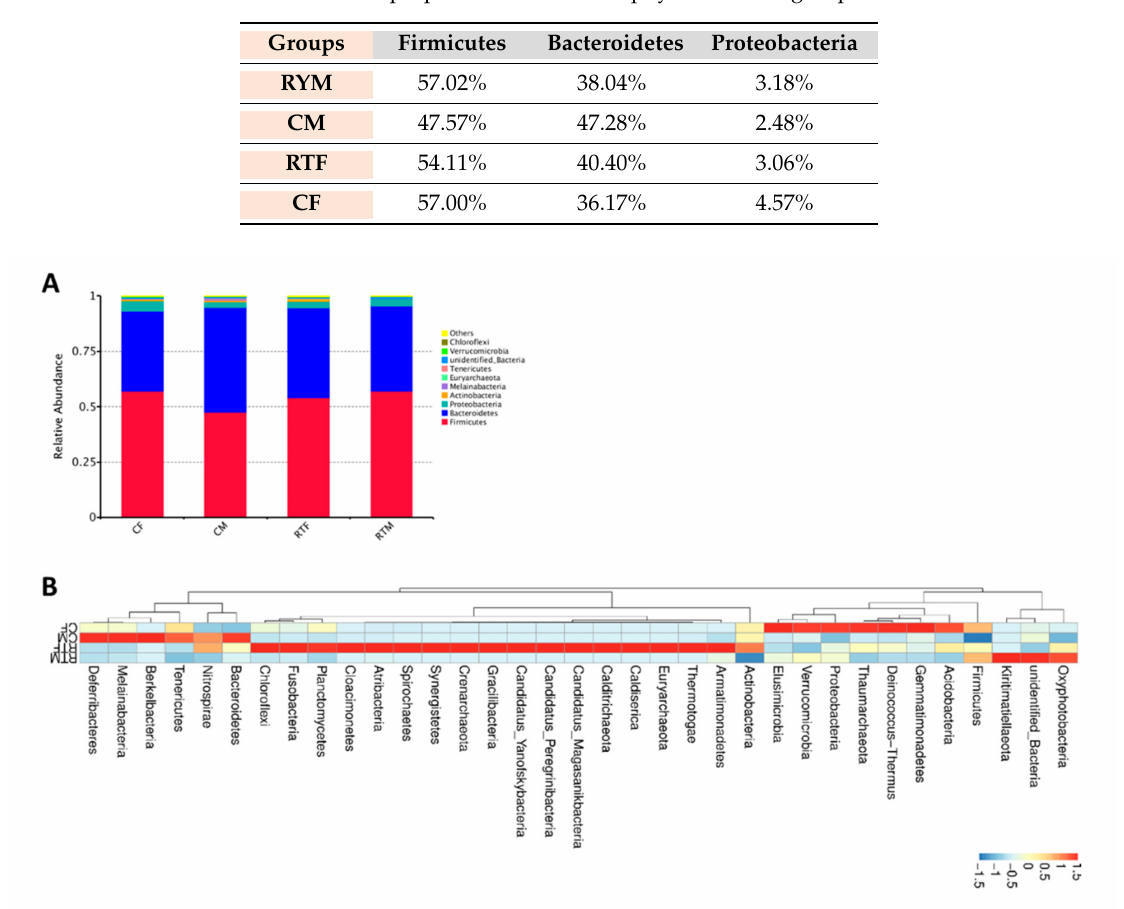
Table 2. The proportion of dominant phylum in each group.